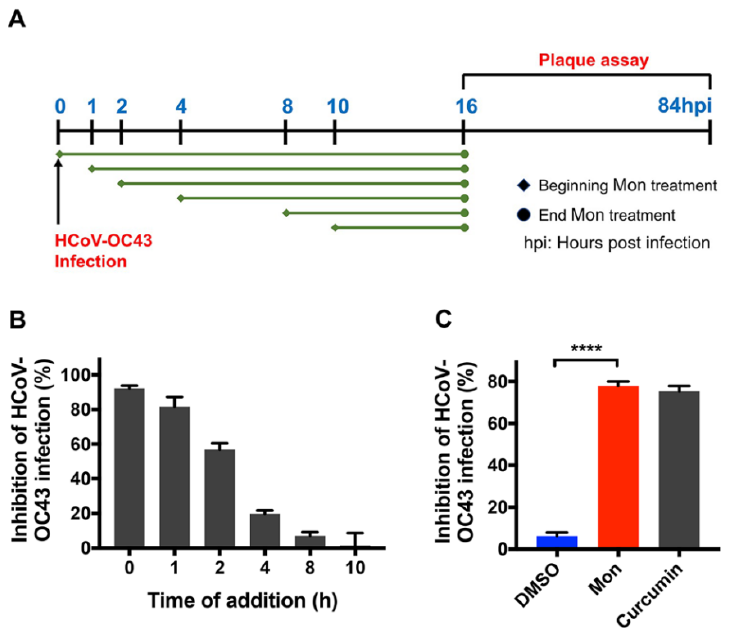
Figure 4. Montelukast (Mon) inhibited HCoV-OC43 infection through blockage of the early stage of the virus lifecycle. ( A ) Outline of time-of-addition experiment. hpi: hours post infection. ( B ) Time-of-addition experiment to study montelukast against HCoV-OC43 infection. Montelukast was administrated at different time point after infection and plaque assay was performed to evaluate antiviral activity of the drug. ( C ) Montelukast blocked HCoV-OC43 attachment to BHK-21 cells. The mixture of virus and montelukast was added to BHK-21 cells monolayer and incubated on ice for 1 h. Then, montelukast and the unbound virions were removed by washing. Curcumin was included as positive control. Data are presented as means ±SD. **** p < 0.0001.